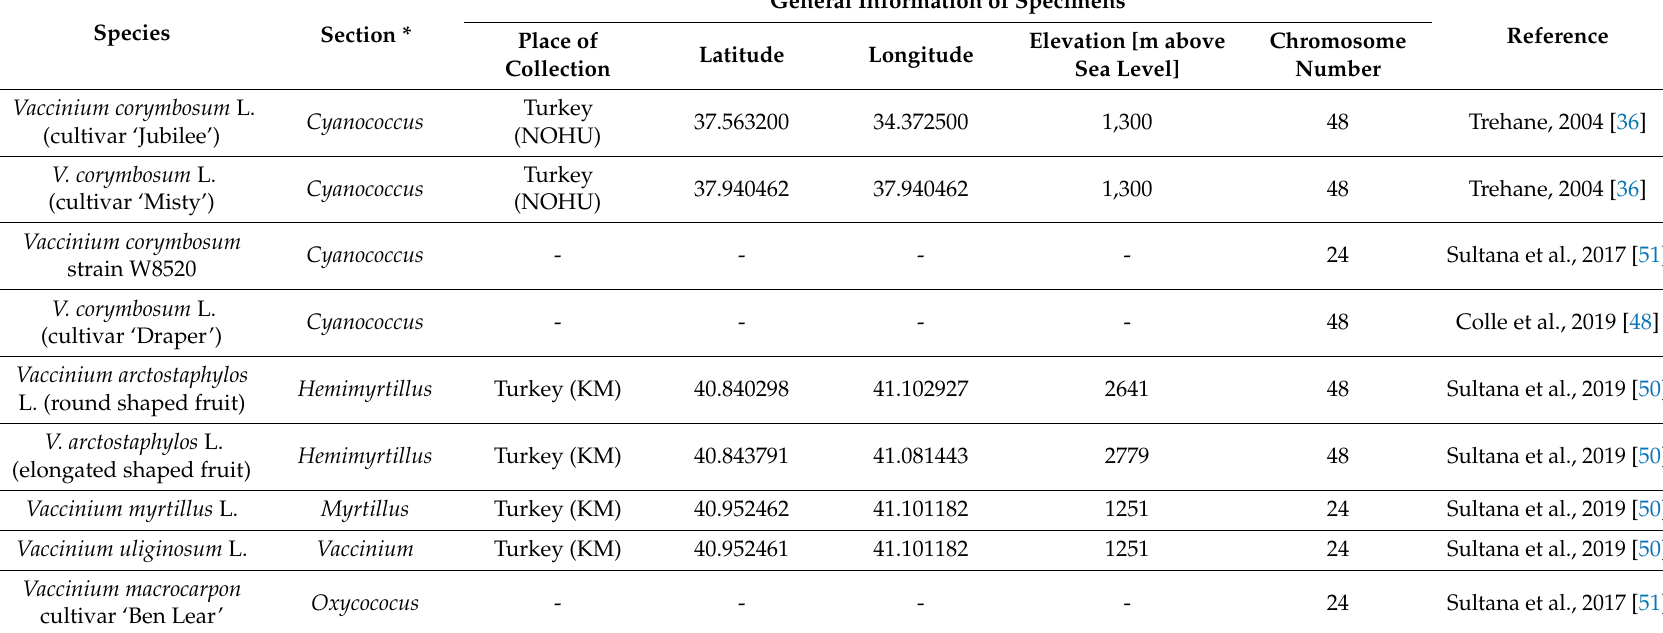
Table 1. Genus, section, origin, location, chromosome number, and reference of the studied Vaccinium species. NOHU = Nigde Omer Halisdemir University, KM = Kaçkar Mountains, Rize,